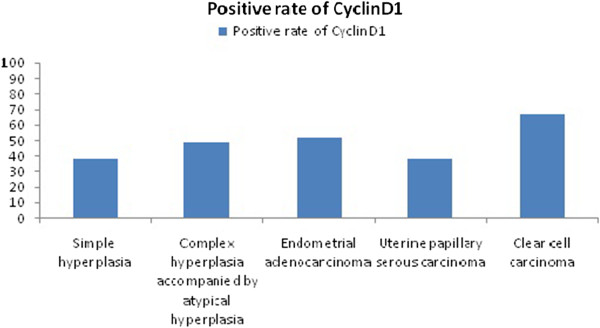
The comparison of the expressions of CyclinD1 in different pathological types of endometrial diseases.